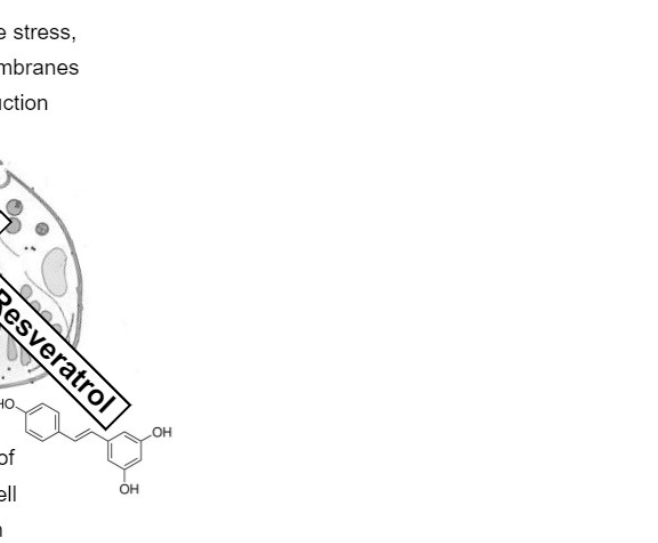
Figure 1. Cellular metabolic pathways affected by ionizing radiation and resveratrol. The diagram illustrates the connections between selected pathways modulated by resveratrol (purple boxes), ra- diation (orange boxes), and both factors (green boxes).